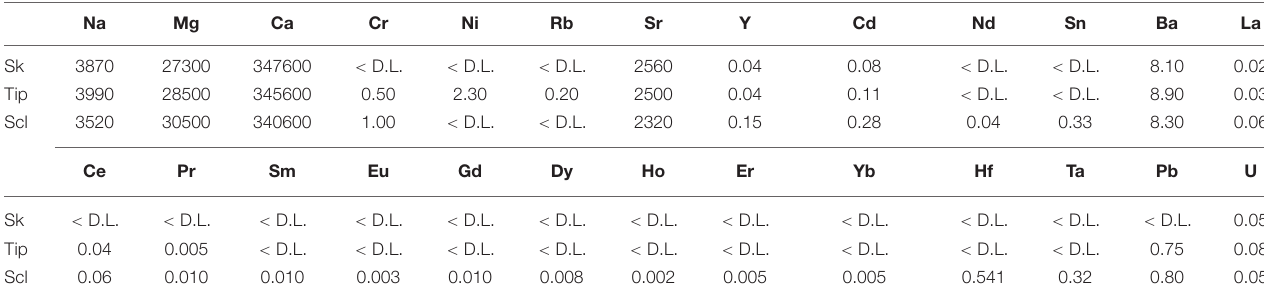
TABLE 3 | Chemical compositions of C. rubrum skeletons (Sk), tips and sclerites (Scl) determined by ICP-AES and ICP-MS (samples Sormiou Canceou and Falaise Voile). Na Mg